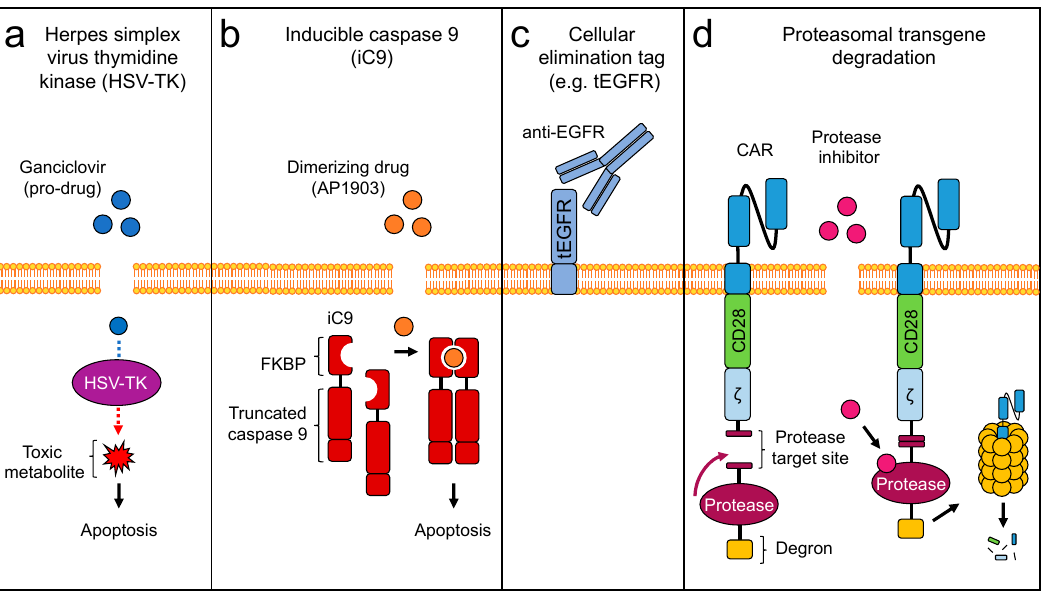
Figure 2. Engineering strategies to enhance safety of ACTs: ( a ) Herpes simplex virus thymidine kinase (HSV-TK). ( b ) Inducible caspase 9 (iC9). ( c ) Cellular elimination tag (e.g., tEGFR) ( d ) Proteasomal transgene degradation.